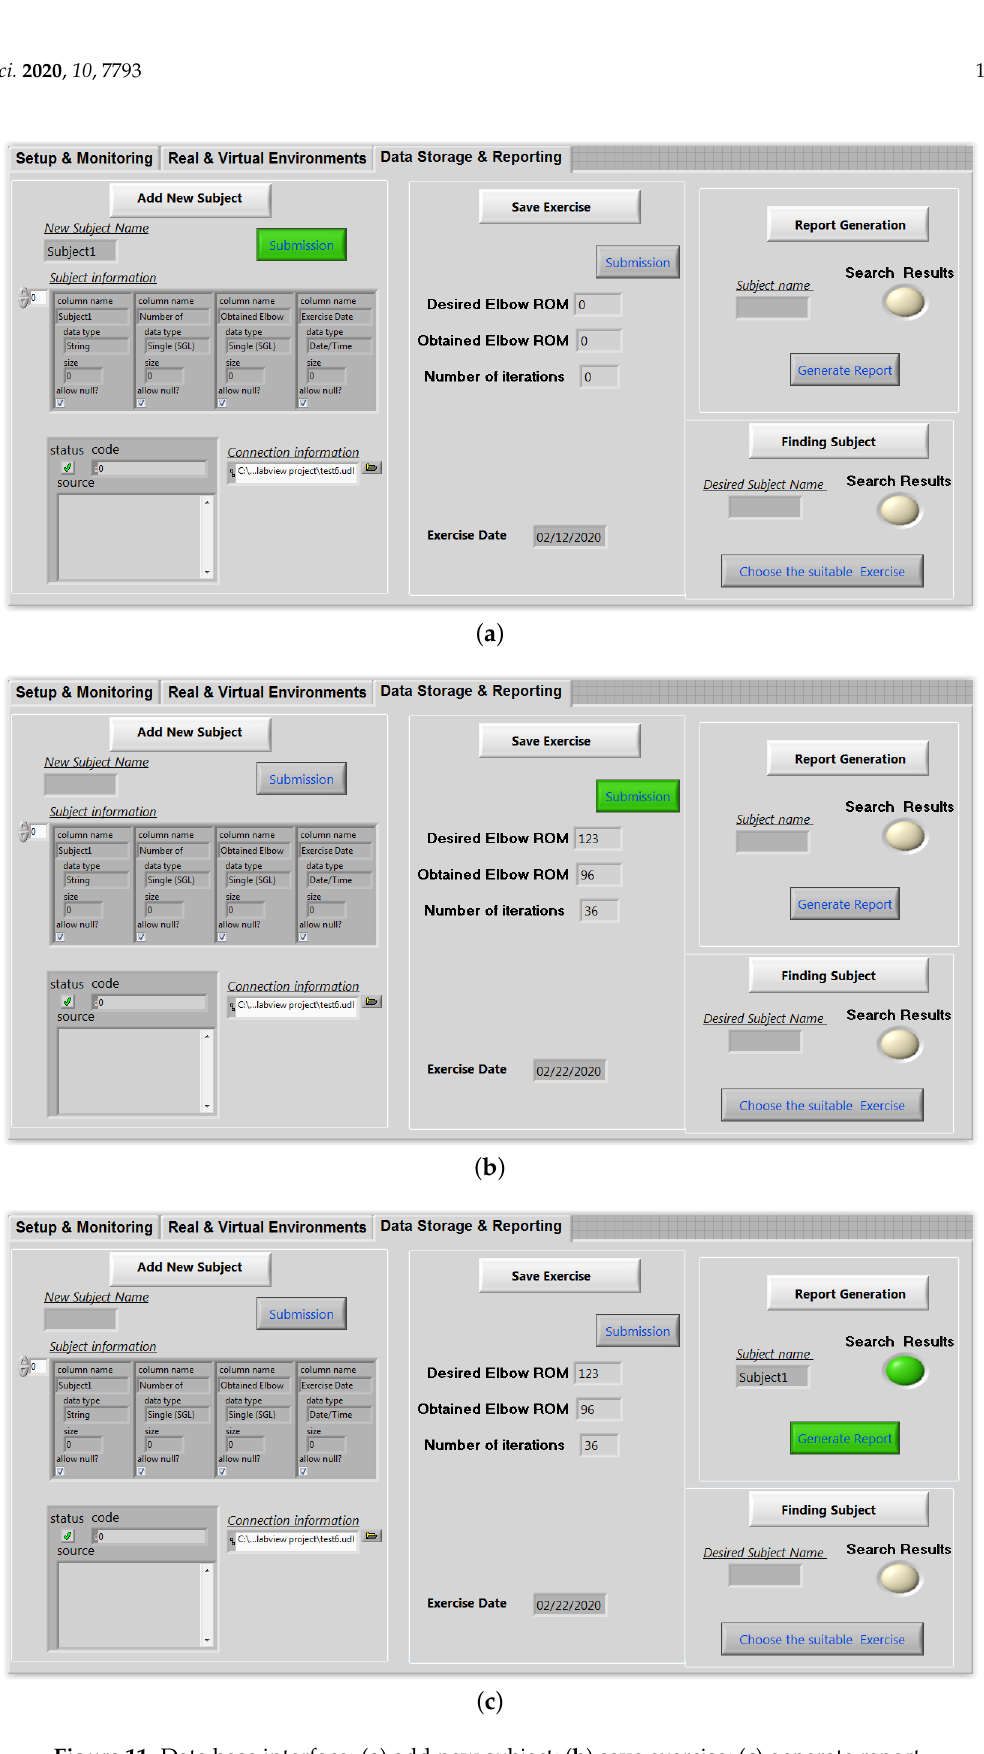
Figure 11. Data base interface: ( a ) add new subject; ( b ) save exercise; ( c ) generate